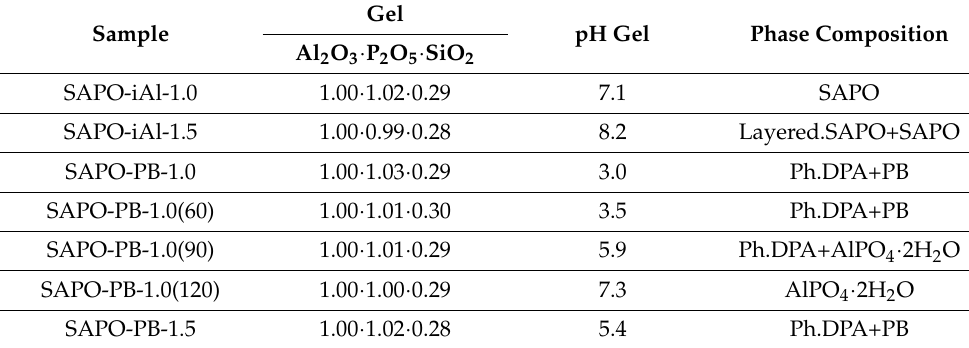
Table 1. Chemical and phase composition of silicoaluminophosphate